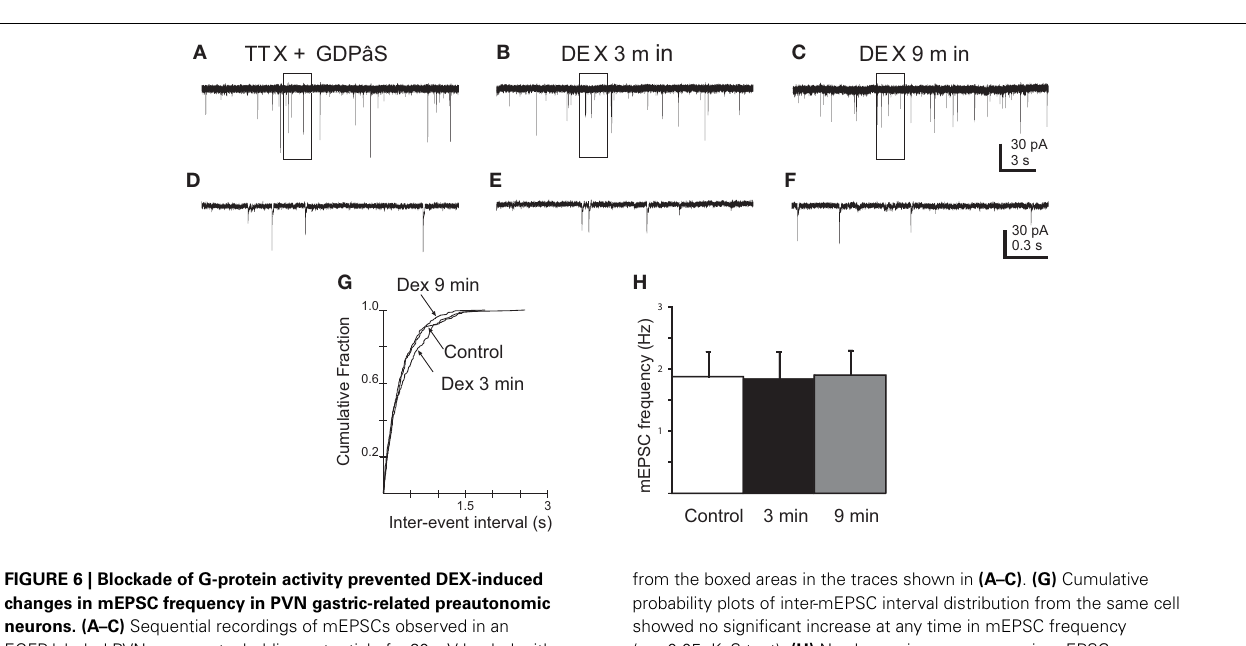
FIGURE 6 | Blockade of G-protein activity prevented DEX-induced changes in mEPSC frequency in PVN gastric-related preautonomic neurons. (A–C) Sequential recordings of mEPSCs observed in an EGFP-labeled PVN neuron at a holding potential of − 60mV loaded with the G-protein inhibitor, GDP β S, during control conditions (A) , after 3 (B) and 9min (C) of bath application of 10 µ M DEX. (D–F) Expanded traces